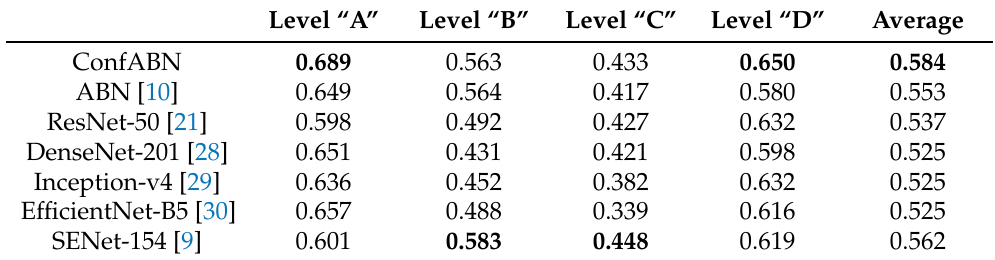
Table 5. F-measure of ConfABN and comparative methods in estimating deterioration levels of